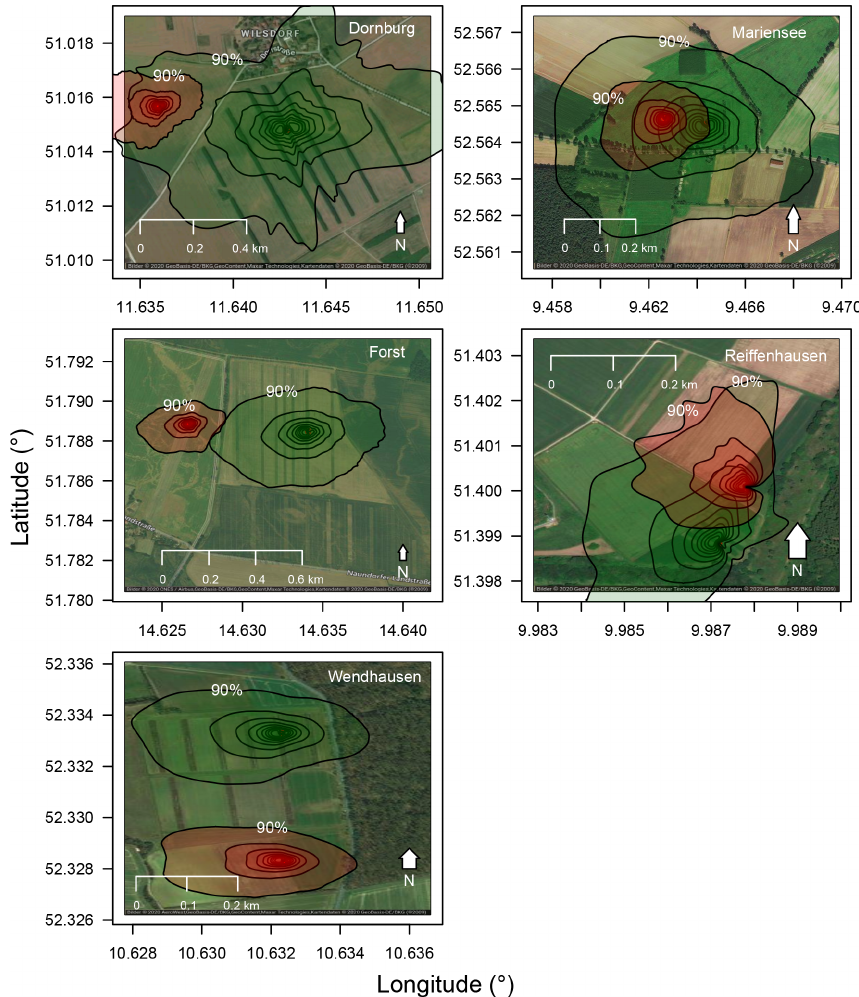
Figure C1. Flux footprint climatology for all sites and all available data during the years 2016 and 2017. Green shaded footprints correspond to the agroforestry system, and red shaded footprints correspond to the monoculture system. For the analysis only daytime data were used ( R G > 20Wm − 2 ). Aerial photographs originate from Google Maps and Google Earth. © Google